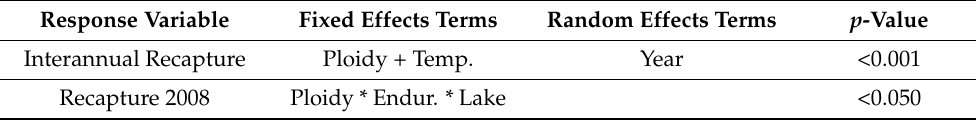
Table 1. Significant terms in statistical models predicting Blackwater rainbow trout ( Oncorhynchus mykiss ) survival in Pete’s Pothole and Bluey Pothole 2. The interannual recapture model was based on the terms year, ploidy and temperature (generalized linear mixed effects model). The 2008 recapture model, aimed at testing for endurance swimming effects on survival, was based on ploidy, endurance and lake (general linear model). *: an interaction; Temp.: temperature; Endur.: Endurance swimming